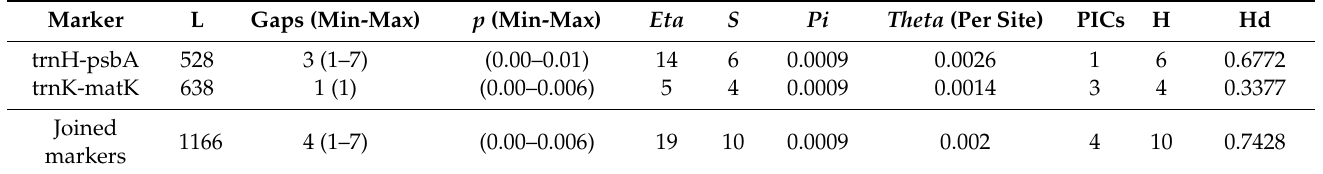
Table 4. cpDNA markers main diversity values in the investigated dataset consisting of 47 chestnut